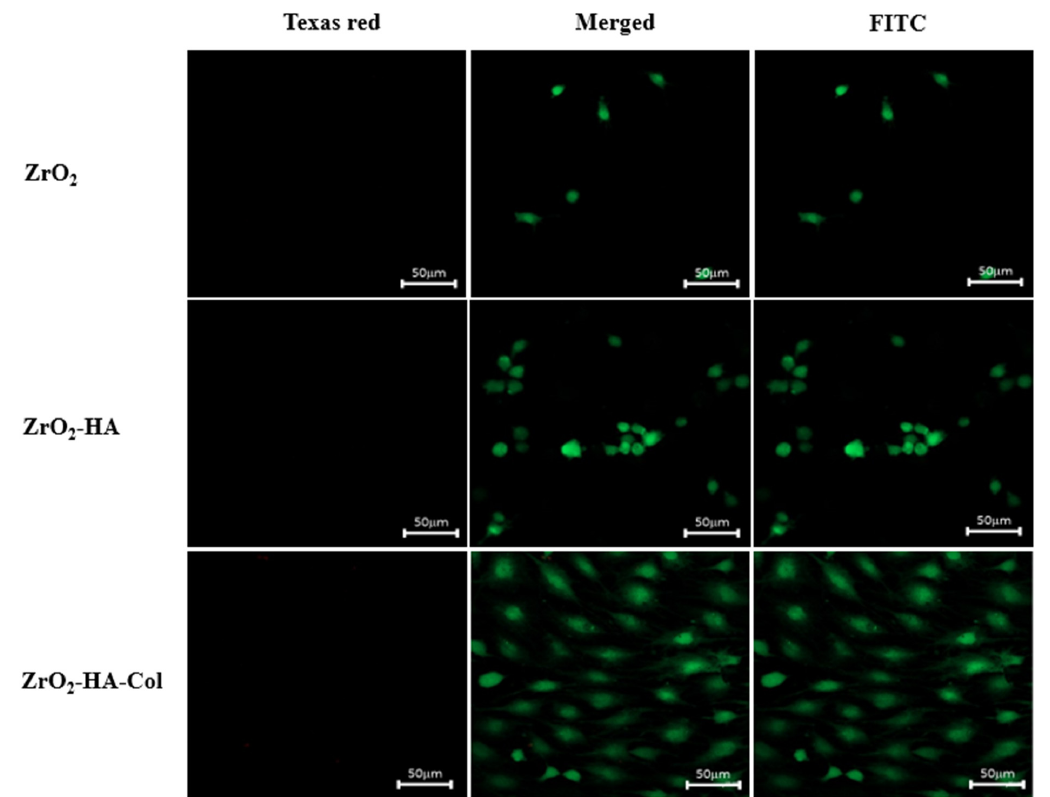
Figure 9. Confocal fluorescence microscopy images of osteoblasts cultured for 3 days on the ZrO 2 , ZrO 2 -HA and ZrO 2 -HA-Col. Cells were stained with Texas red and FITC after culture.